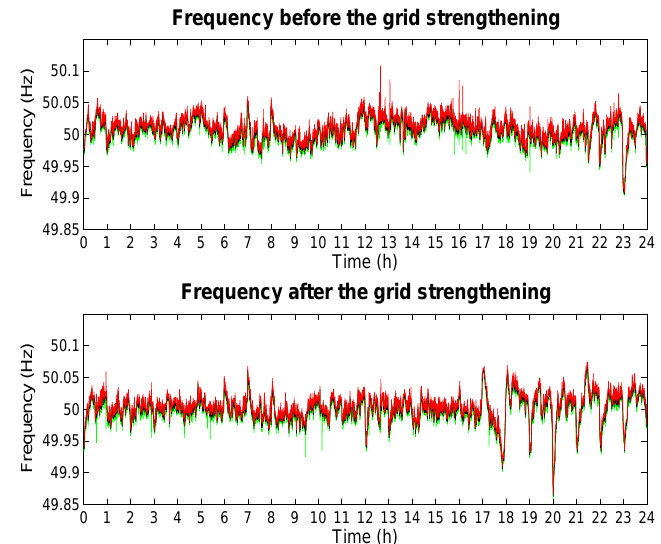
Figure 9. Frequency evolution during one day. Above is the frequency behavior before the grid strengthening. Below is the behavior of the frequency after the grid strengthening. The red line represents the maximum values of the frequency; the black line represents the medium frequency values and the green line represents the minimum values of the frequency.